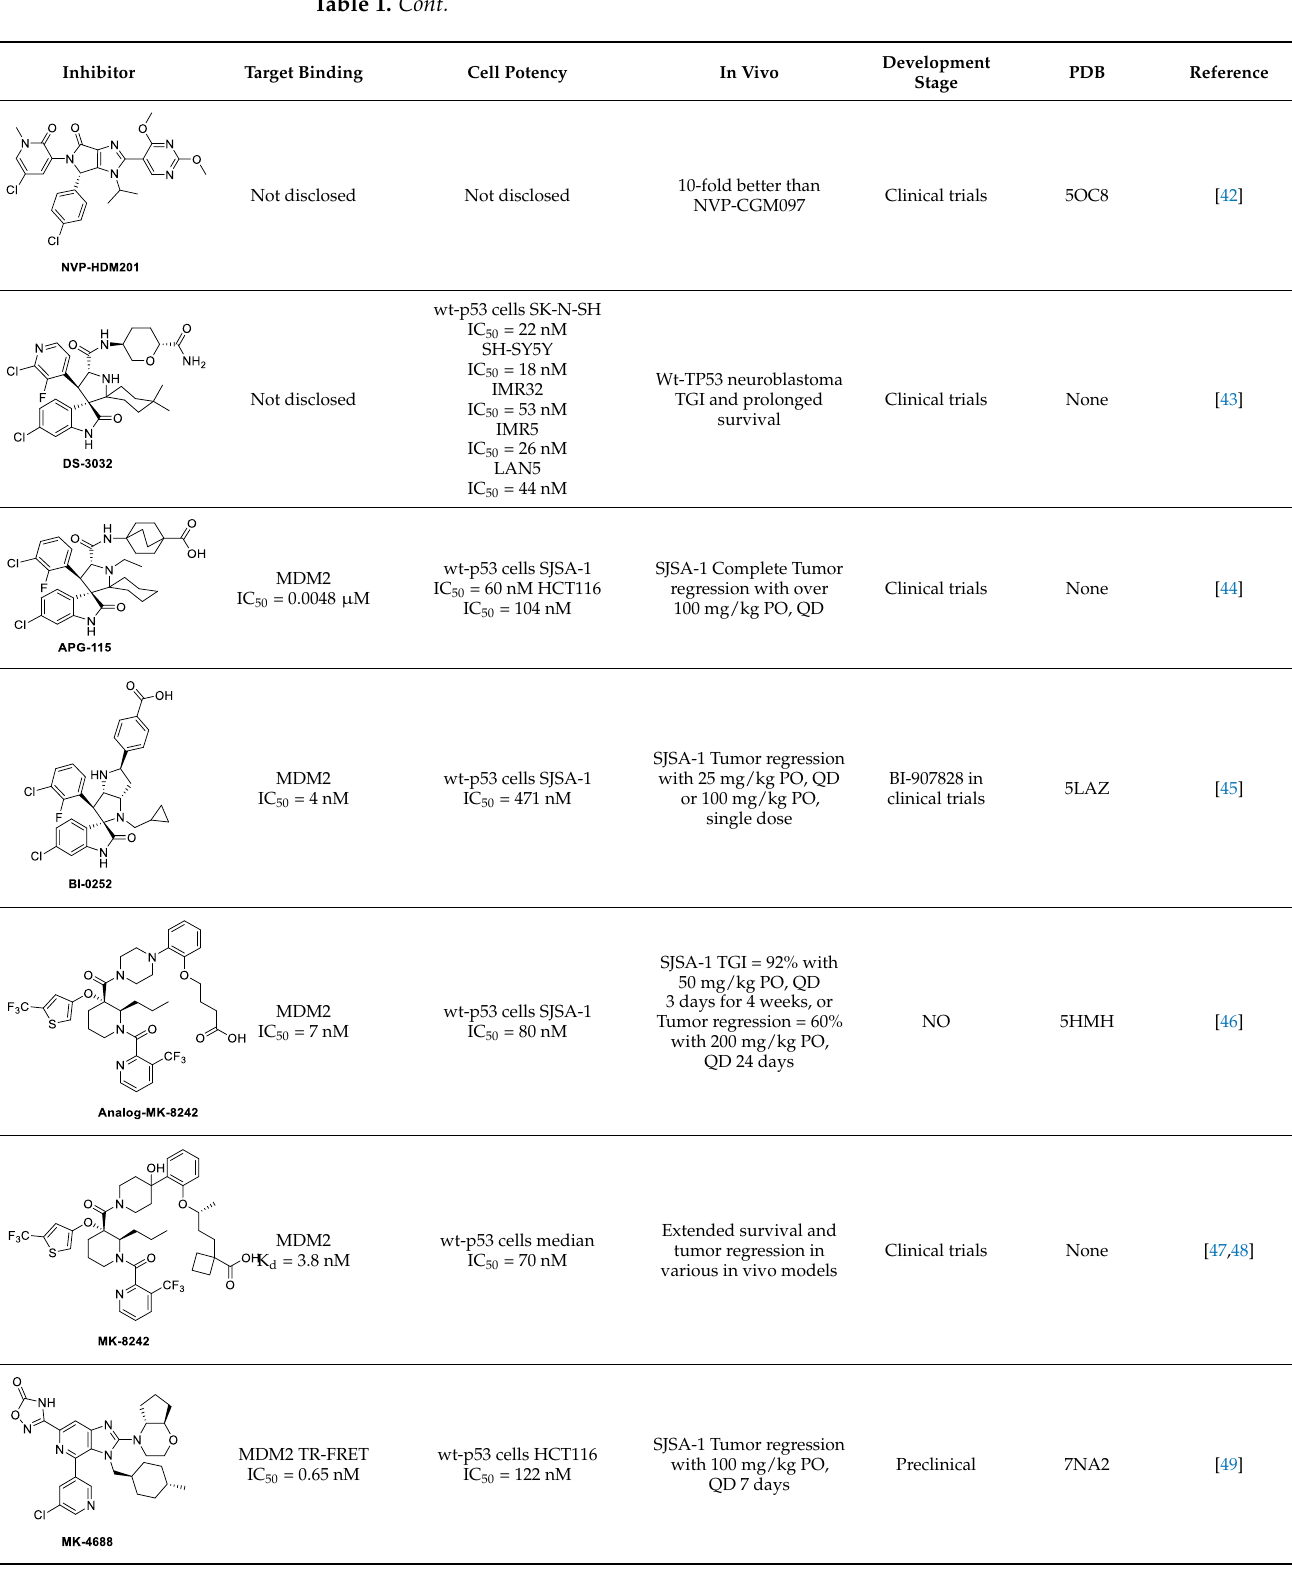
Figure 3. Co-crystal structures and chemical structures of inhibitors bound to MDM2 protein: ( A ) RG7112; ( B ) MI-773; and ( C ) RG7388. Labels and semicircles in magenta indicate the binding pockets